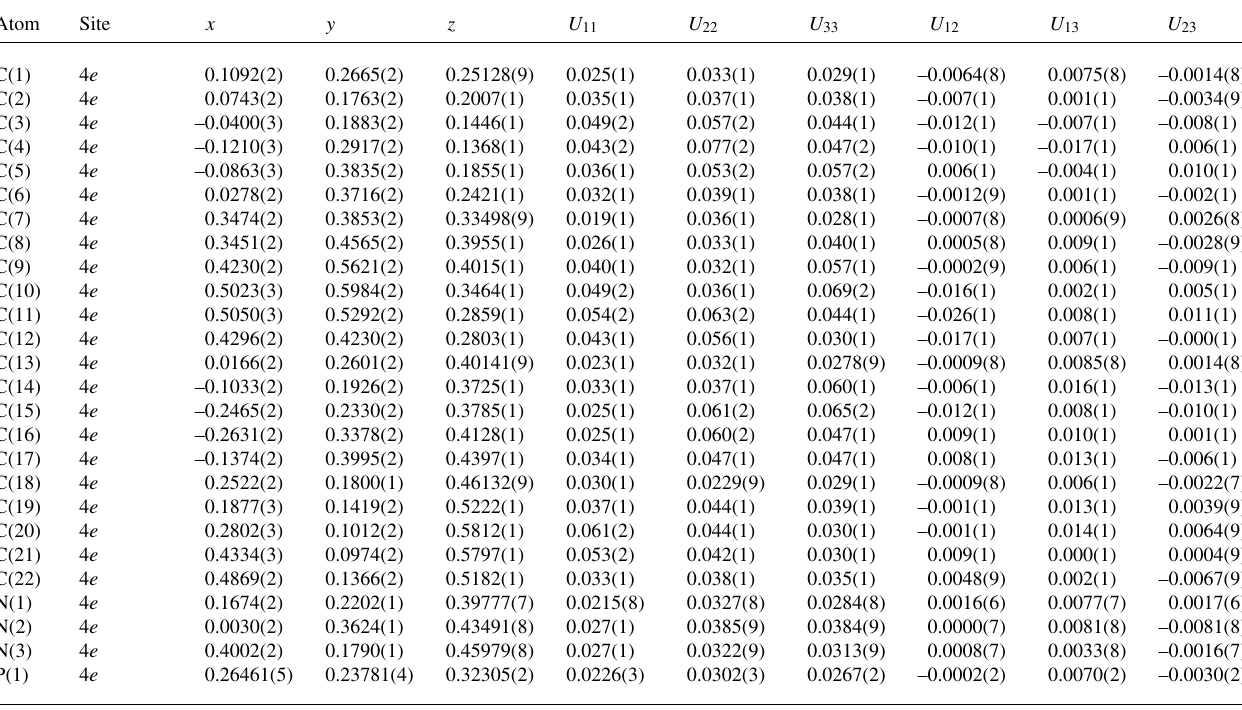
Table 3. Atomic coordinates and displacement parameters (in Å 2 )